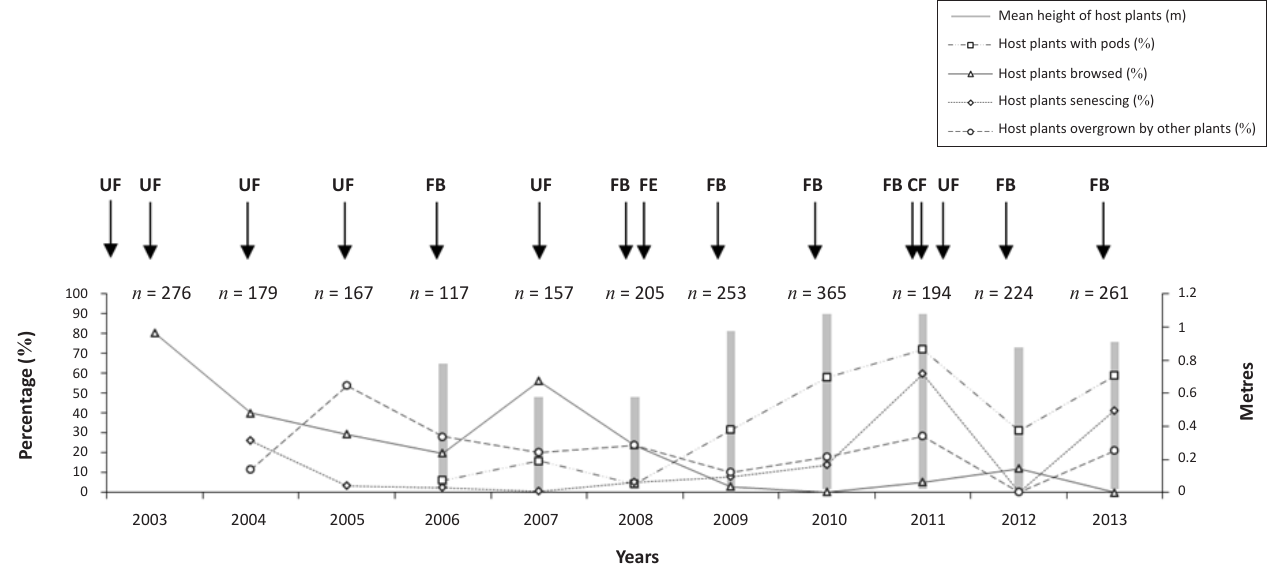
Arrows indicate the occurrence of: UF, uncontrolled fires at the monitoring site; FB, controlled burning of the firebreak around the site; FE, the completion of the fencing of the site; and CF, the occurrence of controlled burning of part of the site. n , host plant sample size. FIGURE 5: Status of the host plants Indigofera woodii var. laxa at the Nkandla monitoring site as recorded during